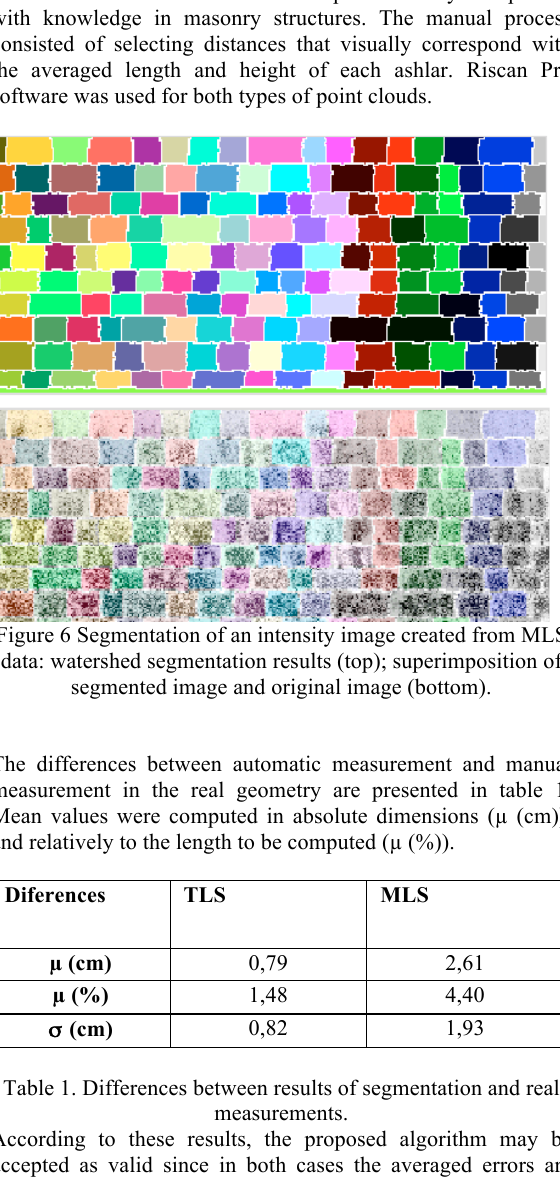
Table 1. Differences between results of segmentation and real